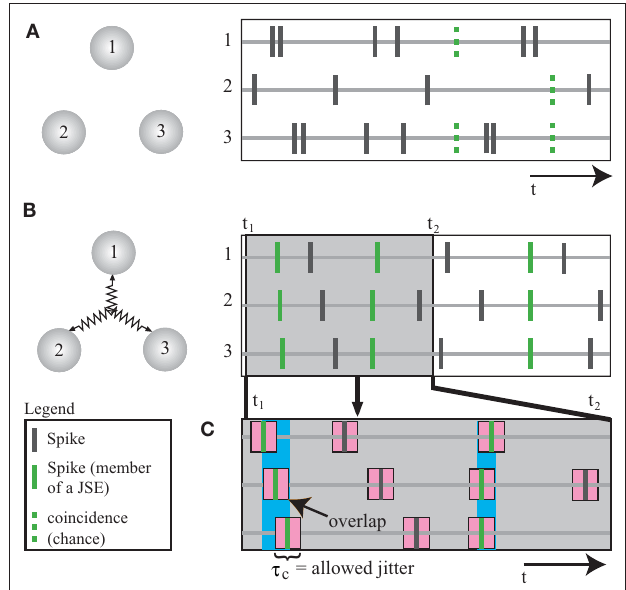
Figure 1 | Detection of synchronized firing patterns. (A,B) Numerals 1–3 stand for three neurons or three neuronal populations. The right sub-panel shows the spike trains. Synchronized spikes (marked in green) are defined as joint-spike-events (JSE). (A) The three units are not coupled, so the spike trains exhibit synchronized spikes that occur at the chance level (indicated by dashed green lines). (B) A third-order coupling between three units. (C) A schematic description of a JSE. Spikes, which are defined as belonging to the same JSE, share overlapping regions within the maximally allowed jitter ( t Modified from a previously published figure (Pipa et